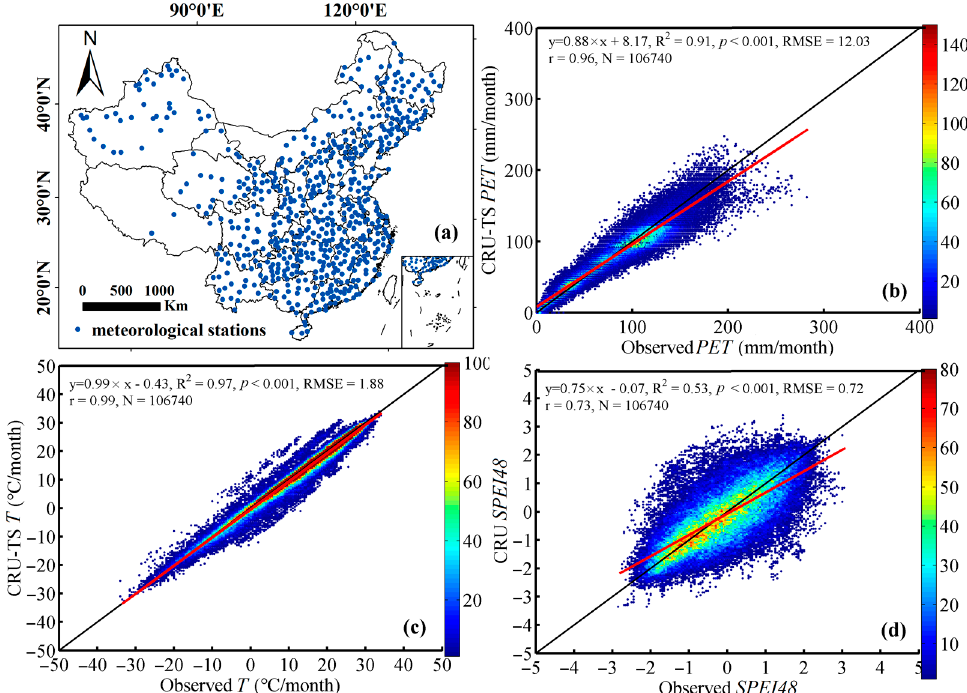
Figure 11. Comparisons of CRU data and the counterparts derived from meteorological stations. ( a ) The spatial distribution of meteorological stations in China (N = 593), ( b ) the potential evapotranspiration, ( c ) the temperature, and ( d ) the SPEI at a time scale of 48 months. The potential evapotranspiration ( PET ) was estimated using the FAO-56 Penman—Monteith method based on six primary variables (i.e., vapor pressure, relative humidity, sun hours, wind speed, and maximum and minimum temperatures) during 1960–2015. The SPEI calculated using the “spei” package in R software (Version 3.6.1). The colors of figures (i.e., b, c, and d) represent the number of data samples, and the red and black line represent the fitting line and 1:1 line, respectively.